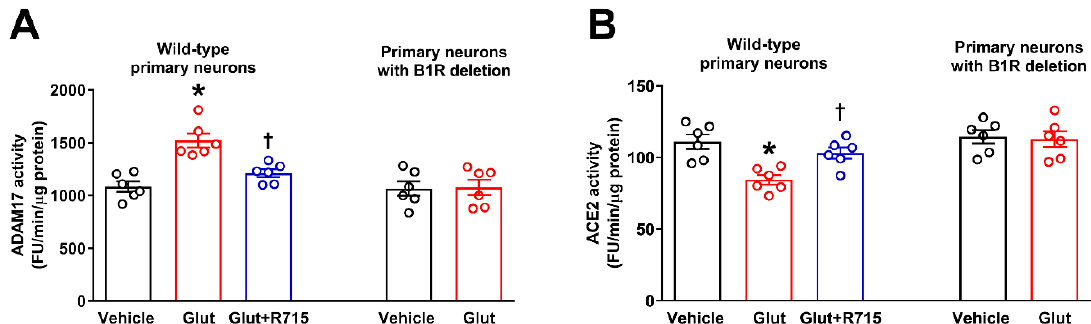
Figure 5. Glutamate-induced ADAM17-mediated ACE2 shedding involves kinin B1R activation. Glutamate increased ADAM17 activity ( A ) and decreased ACE2 activity ( B ) in neurons, which was prevented by pre-treatment with R715. Treatment of B1R knockout neurons with glutamate did not show any effect on ADAM17 or ACE2 activity. ADAM17 and ACE2 assays were performed in primary hypothalamic neurons cultured from wild-type and B1R knockout neonates, treated with glutamate (Glut, 100 µ M) or glutamate with 1 h of pre-treatment with R715 (a specific B1R inhibitor, 10 µ M) for 18 h ( n = 6 independent cultures/group). Statistical significance: one-way ANOVA followed by Tukey’s multiple comparisons test. * p < 0.05 compared to vehicle, † p < 0.05 compared to glutamate.